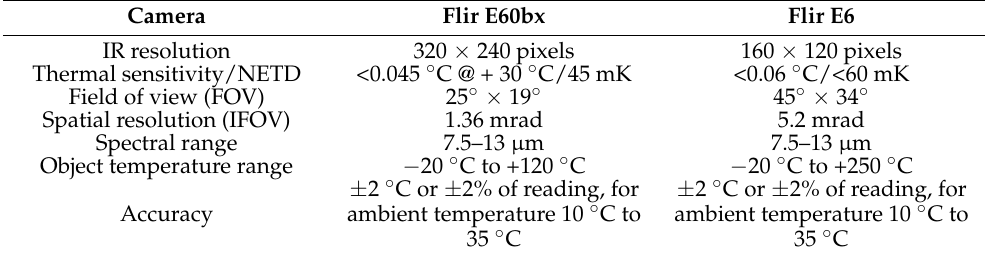
Table 1. Comparison of cameras used for imaging and analysis, FLIR E60bx and E6.